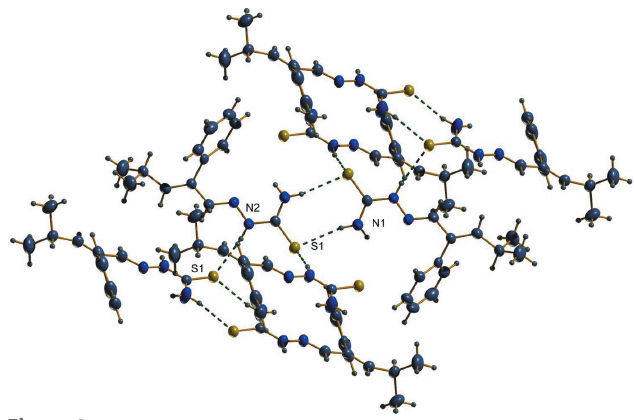
Figure 2 N—H (cid:3)(cid:3)(cid:3) S hydrogen-bonding interactions (dashed lines) in the title